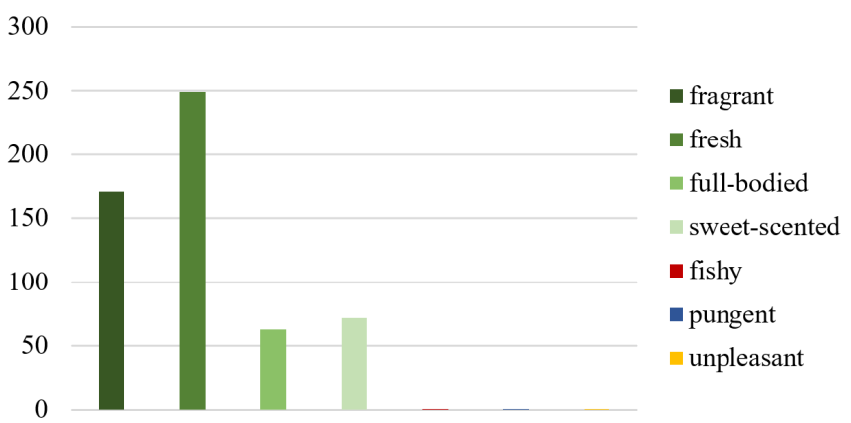
Figure 9. Children’s perceptual descriptions of flowers, trees and soil in the urban forest parks ( n = 334).